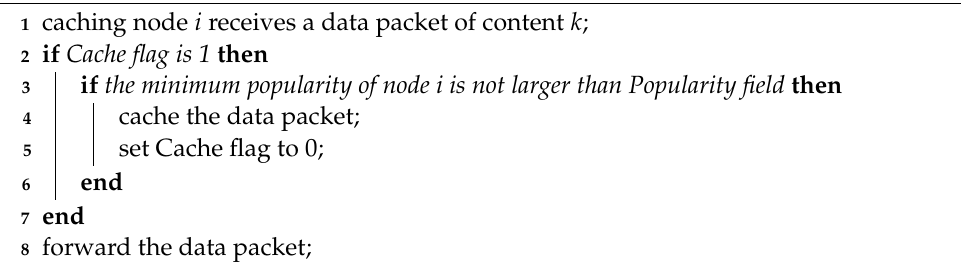
Algorithm 5: Data Packet Forwarding